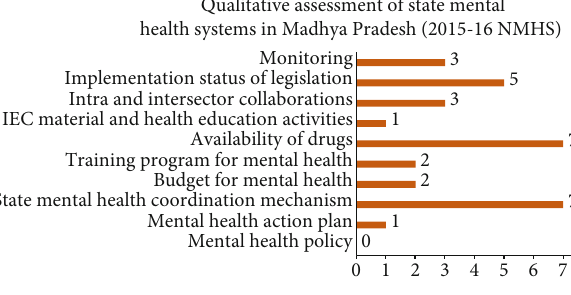
Figure 2: Qualitative assessment of state mental health system in Madhya